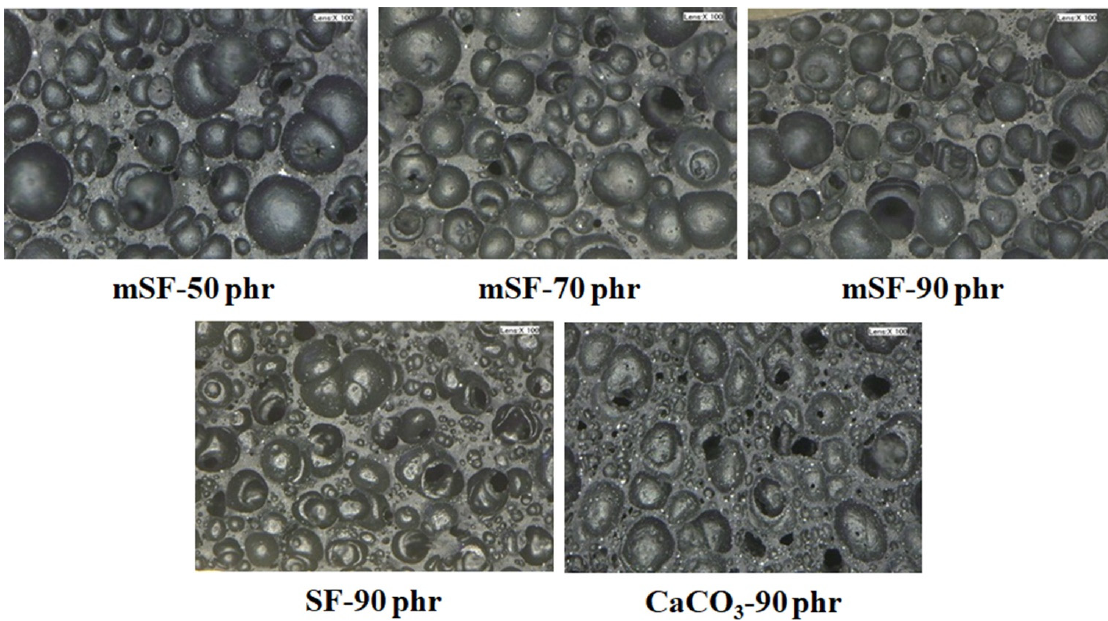
Figure 3. EPDM foam structures using SF, mSF and calcium carbonate as a rubber filler.